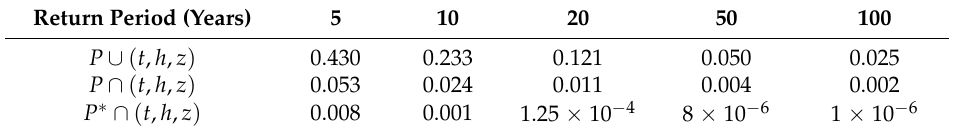
Table 8. Joint probability (P ∪ ) and co-occurrence probability (P ∩ ) of typhoons, rainfall, and storm surges. Return Period (Years)